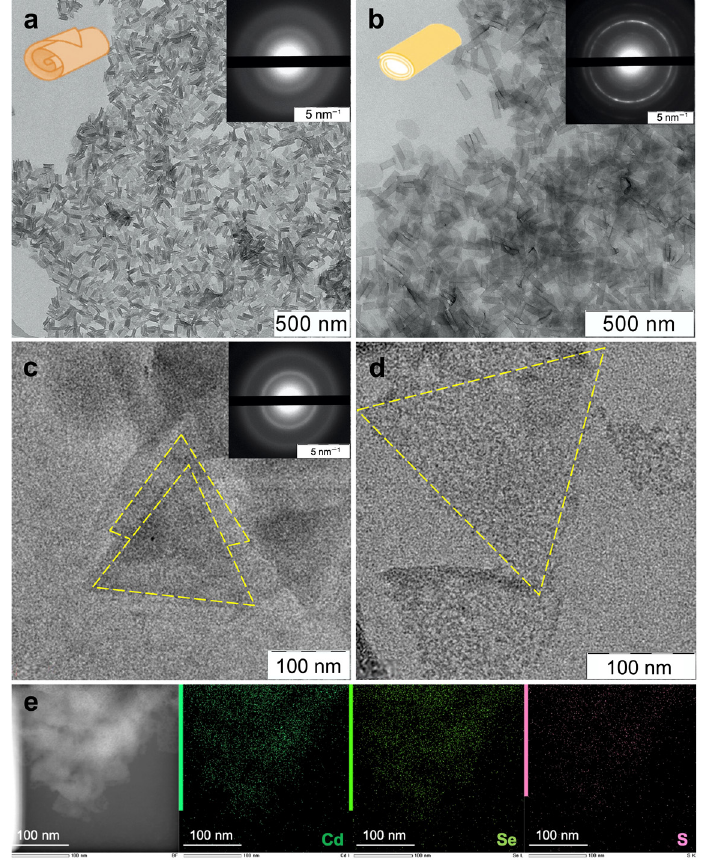
Figure 1. Low-magnification TEM images of ( a , c ) as-synthesized scroll-like CdSe394OA and triangular ZnSe293OA NPLs covered with oleic acid ligands and ( b , d ) the same NPLs after ligand exchange with L-AcCys. Inserts show electron diffraction images. ( e ) EDX mapping of CdSe394 covered with L-AcCys ligand.